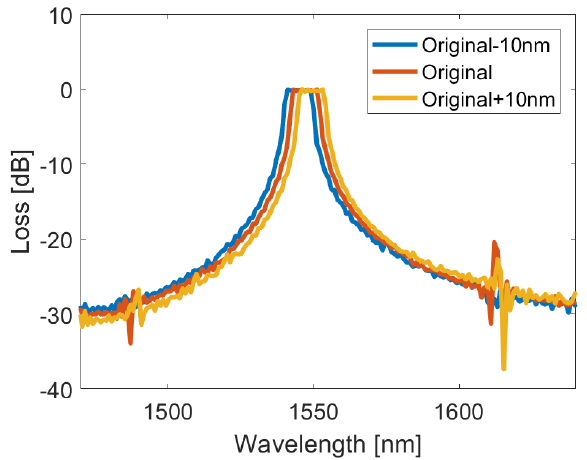
Figure 5. Fabrication error induced central wavelength shift for C4.